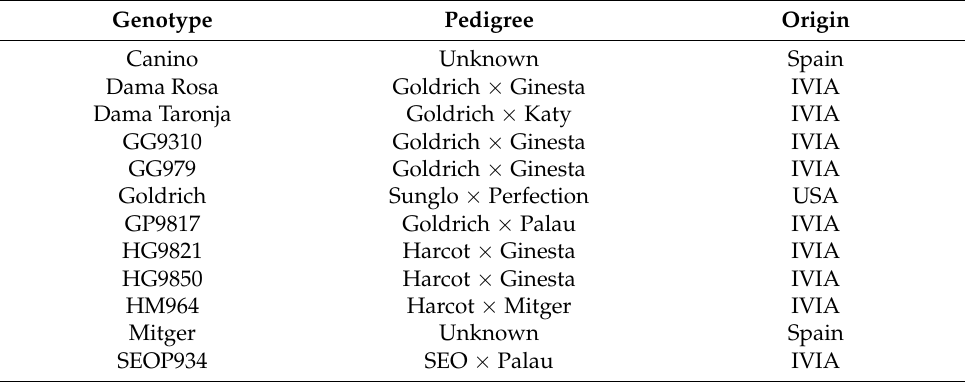
Table 5. Plant material used in the study, pedigree, and